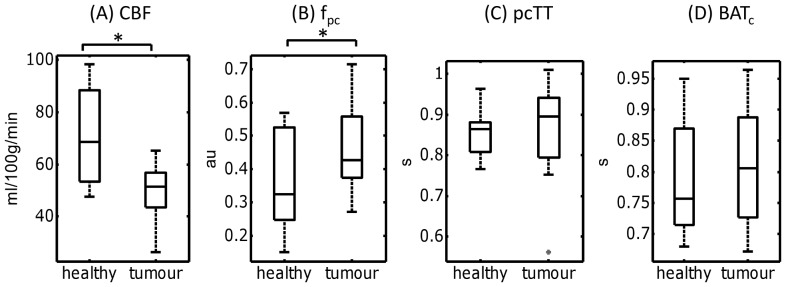
Comparison of fitted parameters from the two-stage ASL model in tumour tissue and contralateral healthy gray matter.Box and whisker plots of mean fitted values of (A) cerebral blood flow (CBF), (B) pre-capillary blood volume (fpc), (C) pre-capillary transit time (pcTT) and (D) bolus arrival time at the capillaries (BATc). Data are shown for healthy tissue and tumor regions in all patients, with horizontal lines  =  group median, box edges  = 25th and 75th percentiles, and outliers (+) defined as values larger than q3+1.5*(q3−q1) or smaller than q1−1.5*(q3−q1). Significant difference between groups, determined using a two-tailed paired t test, is indicated by * (p<0.05).